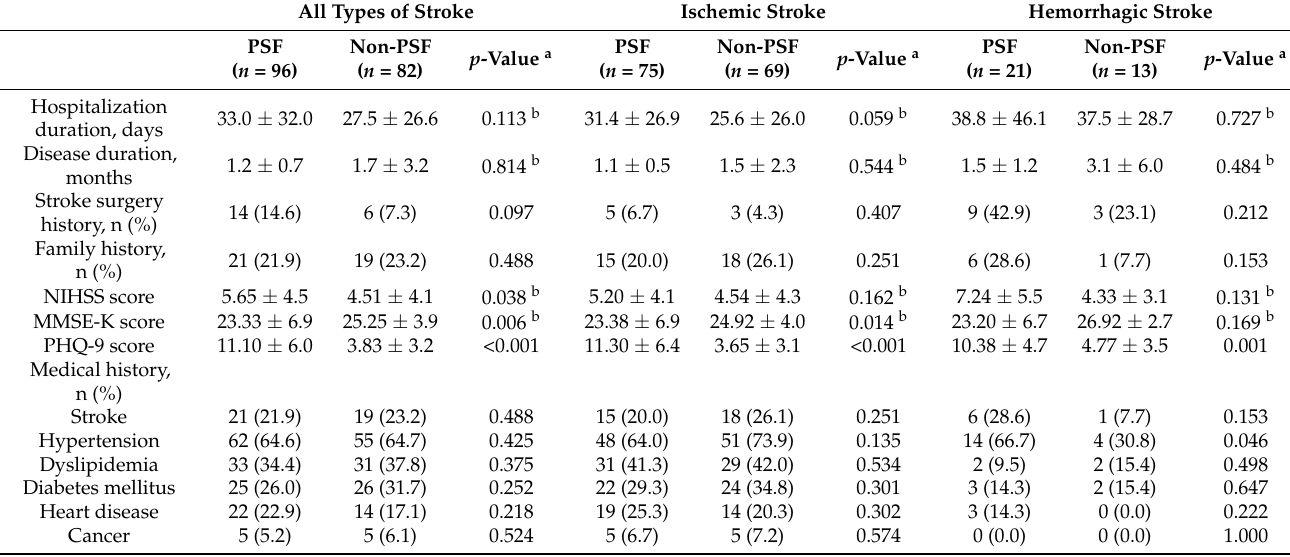
Table 2. Comparison of disease characteristics between the PSF and non-PSF